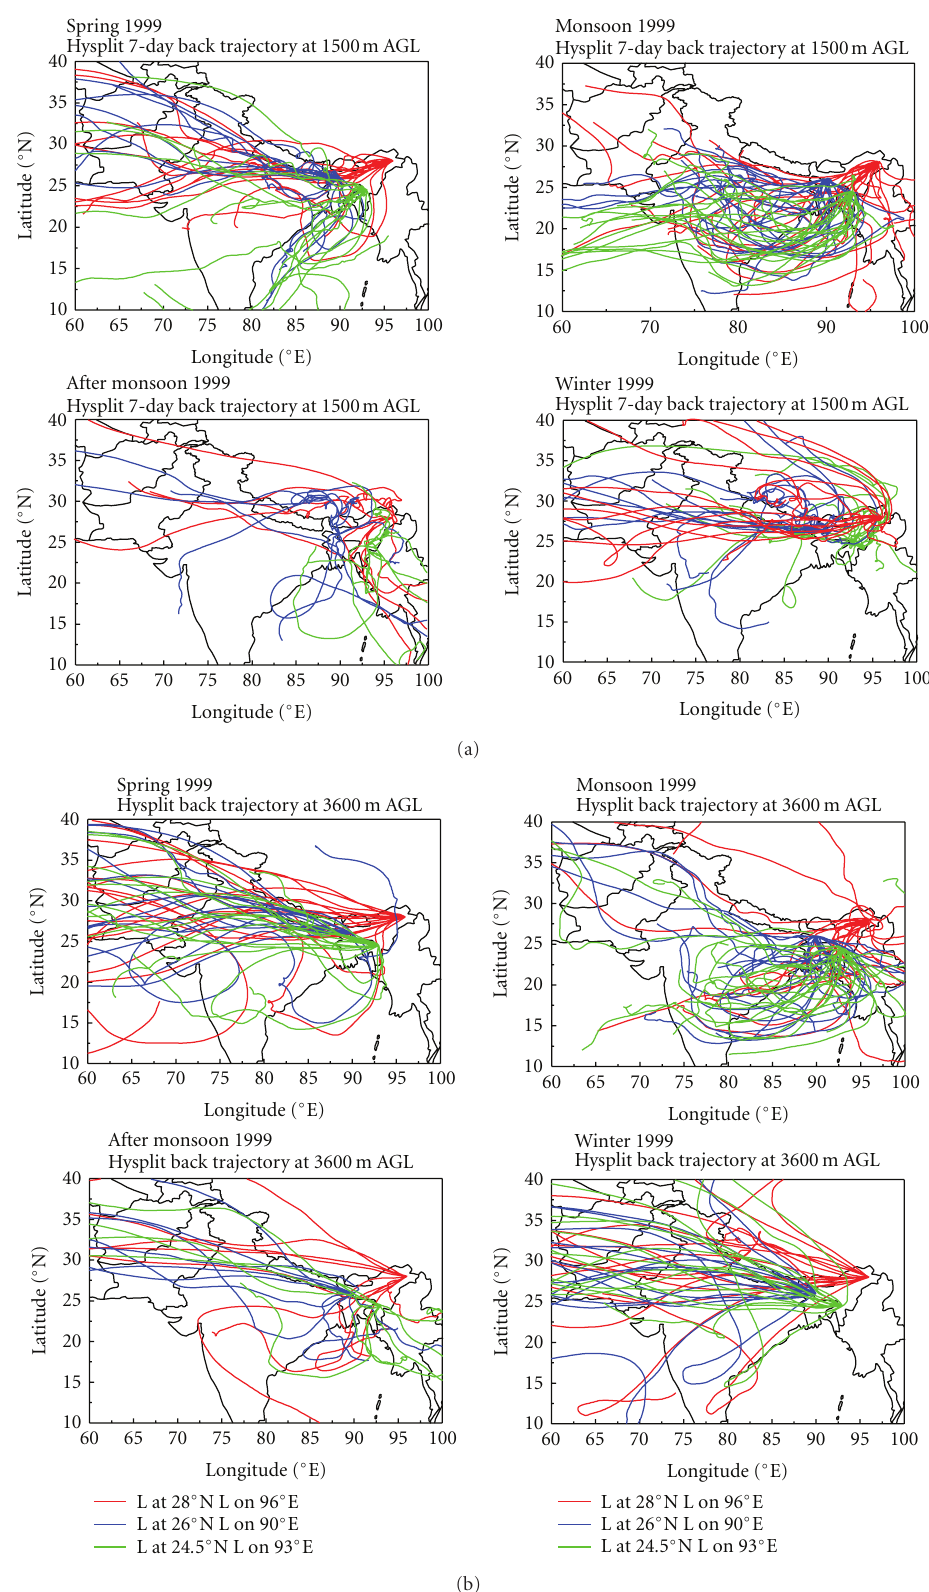
Figure 6: (a) Seasonal 7-day air back trajectory at 1500 m above ground level (AGL) for the year 1999 at the three di ff erent points of NE. (b) Seasonal 7-day air back trajectory at 3600 m above ground level (AGL) for the year 1999 at the three di ff erent points of